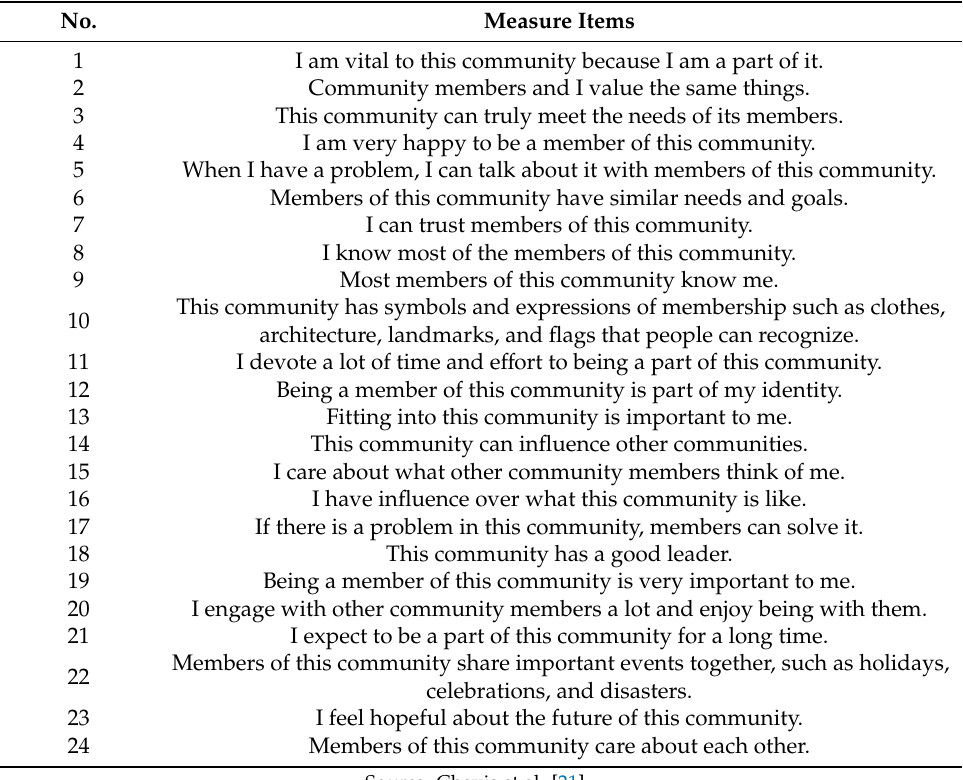
Table 1. Measurement items for sense of